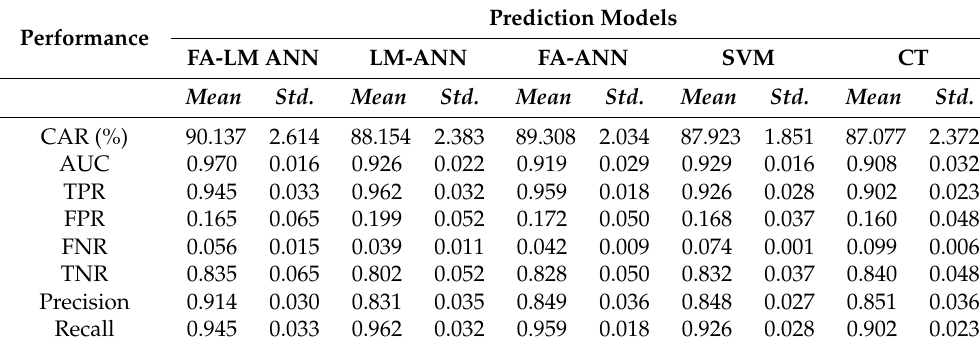
Table 5. Result of the 10-fold cross validation process.